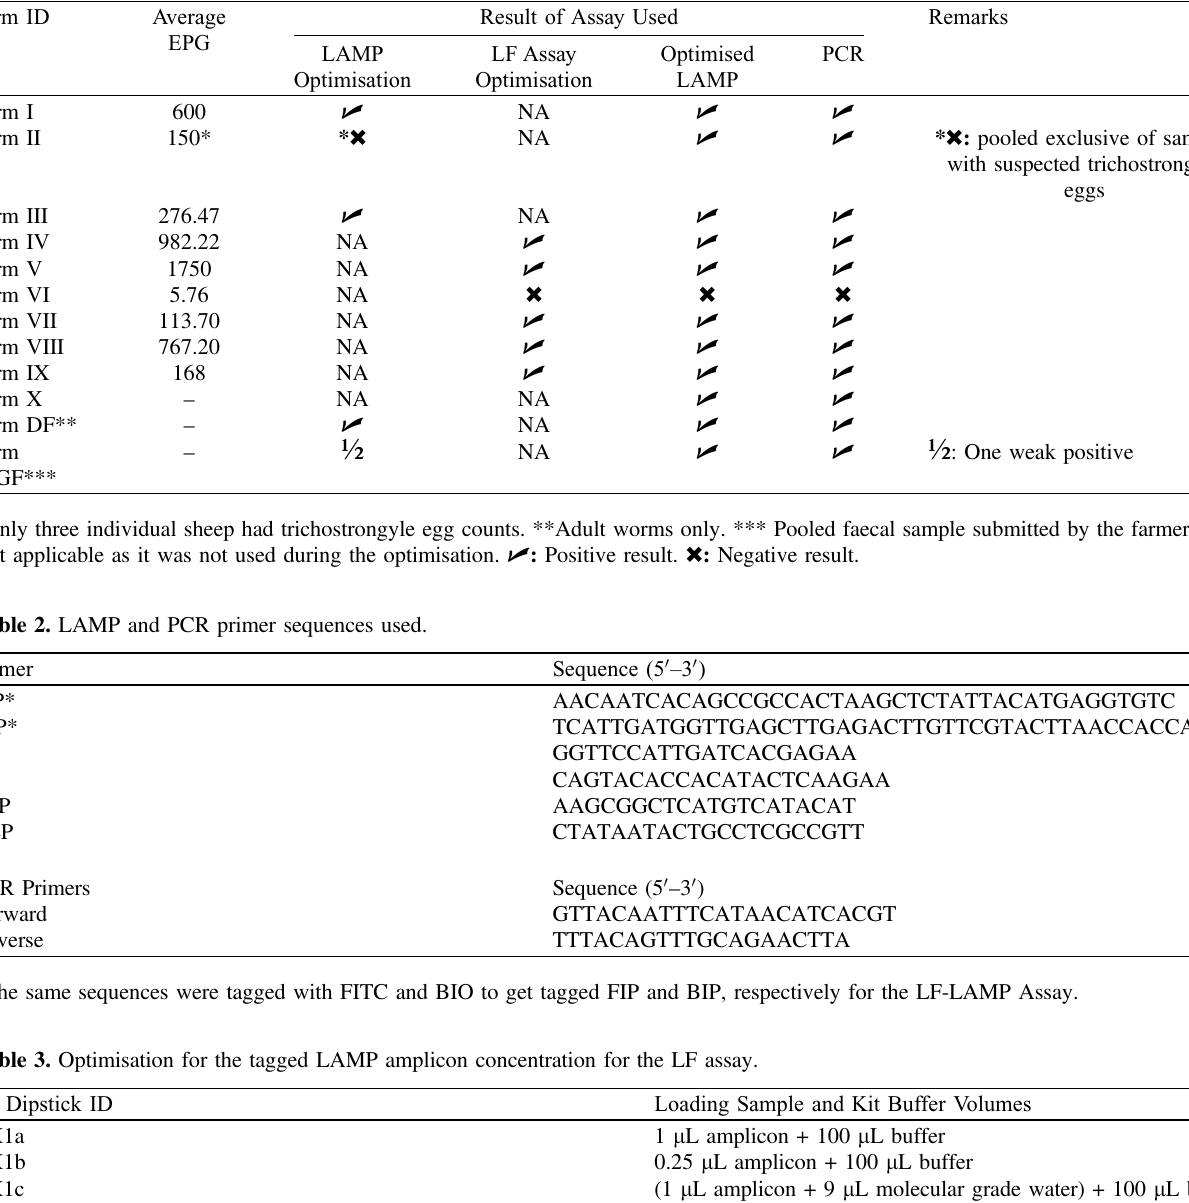
Table 1. Average EPG of the farms ( n > 25 sheep per farm) used in the respective assay designs. Farm ID Average Result of Assay Used EPG